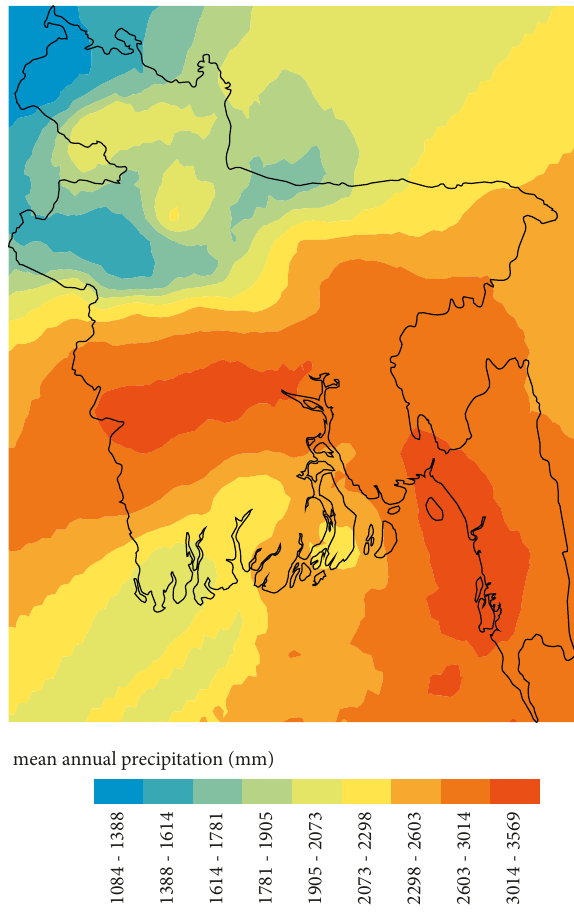
Figure 5: Spatial distribution of mean annual precipitation by (a) observation, (b) GBR, (c) RF, (d) SVM, and (e) MLR in Bangladesh from 1989 to